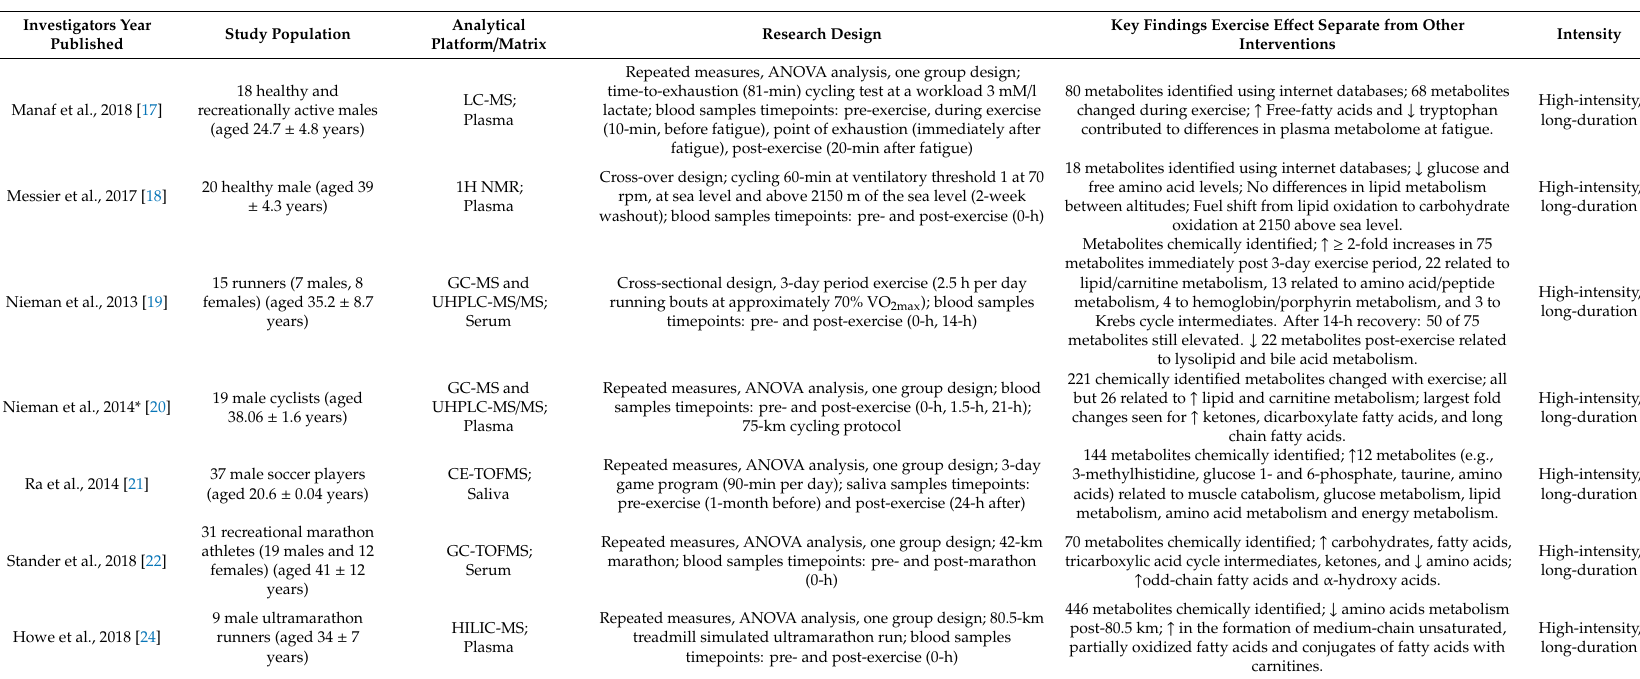
Key Findings Exercise E ff ect Separate from Other Interventions Intensity